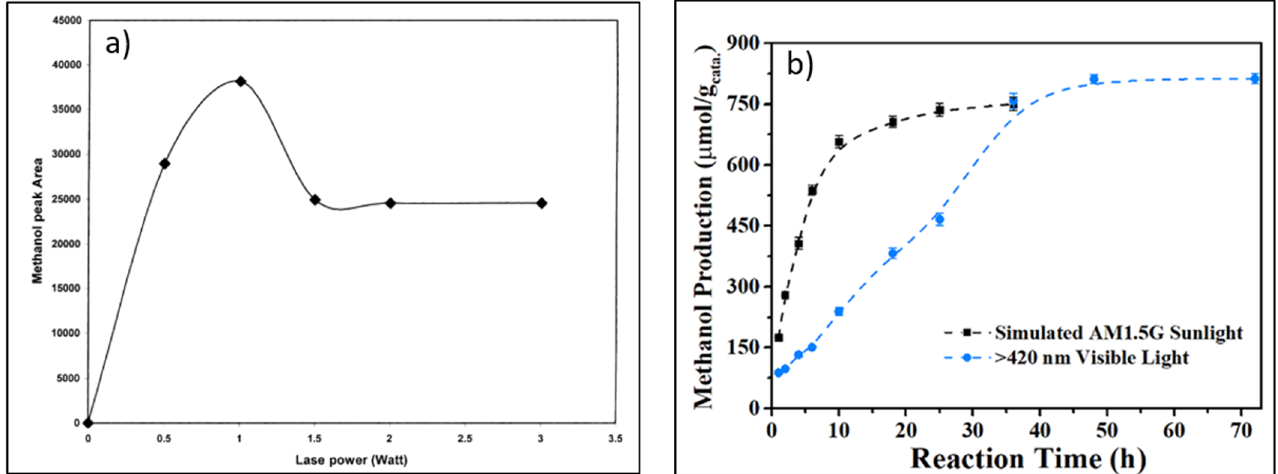
Figure 32. Methanol production in different light sources was reported by ( a ) Gondal et al. [29] and ( b ) Shi et al. [117]. Reproduced with permission from Gondal et al. Copyright © 2022 Elsevier and Shi et al. Copyright © 2022 John Willey & Sons, Inc.